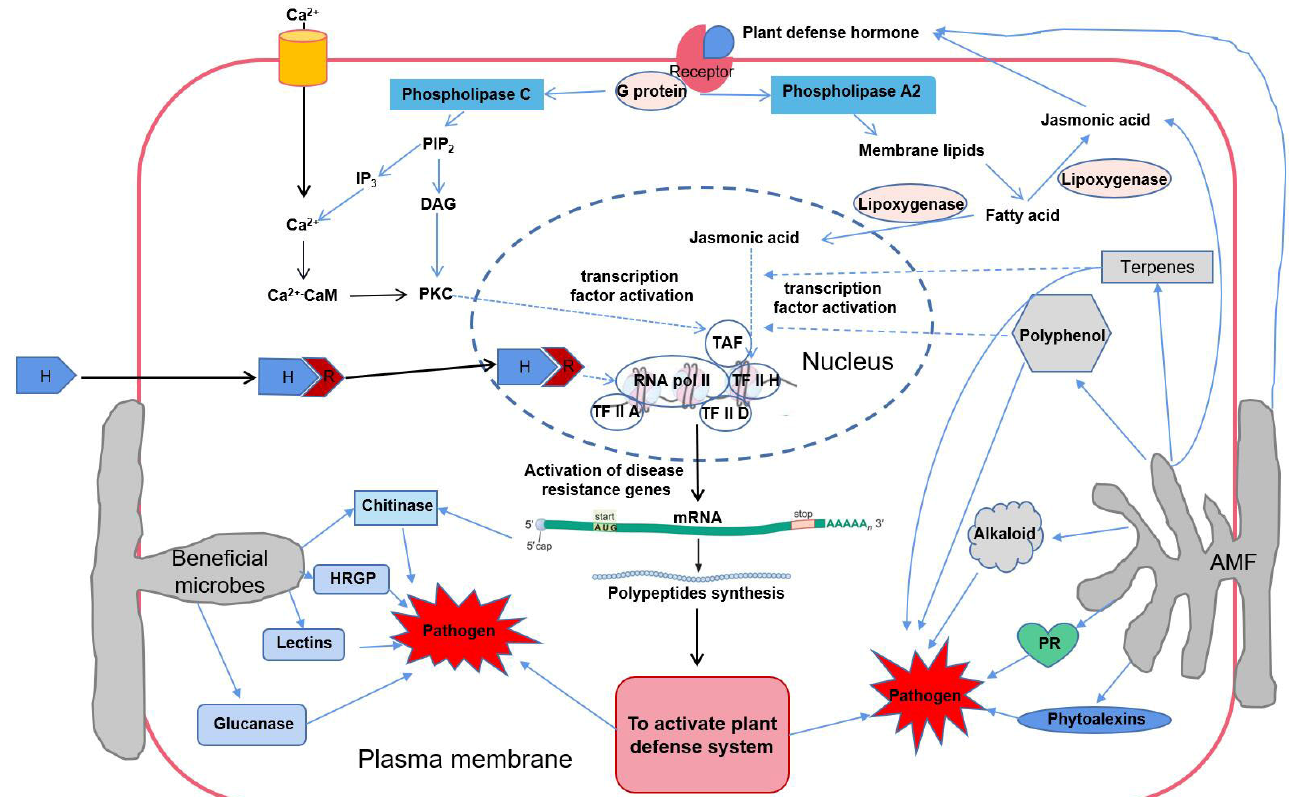
Figure 3. Schematic diagram of the mechanism of action of AMF in activating plant defense systems.